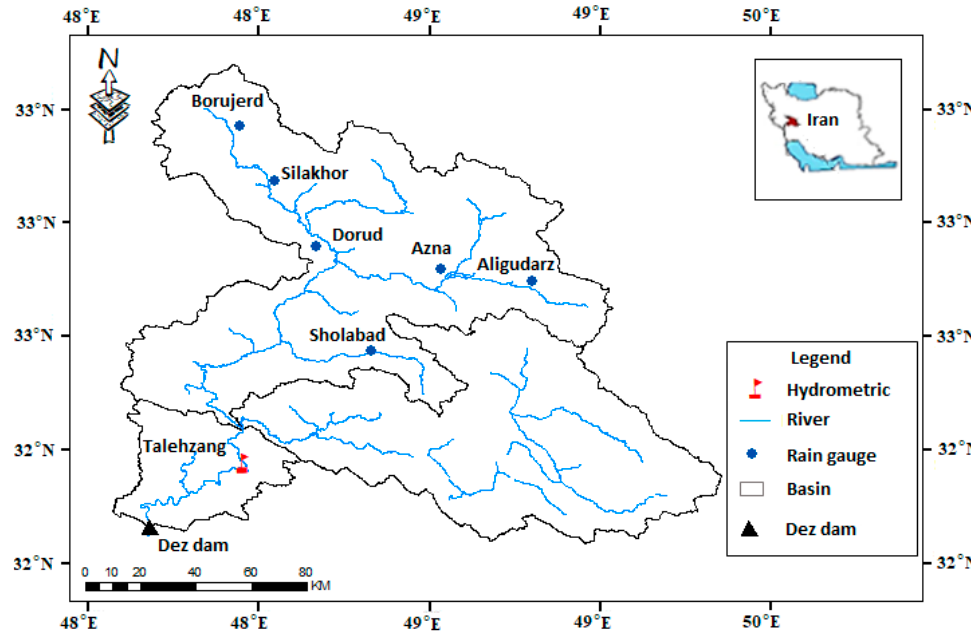
Figure 2. The location of the Dez basin, rain gauges, and the hydrometric station. Table 1. Observed precipitation and streamflow data.